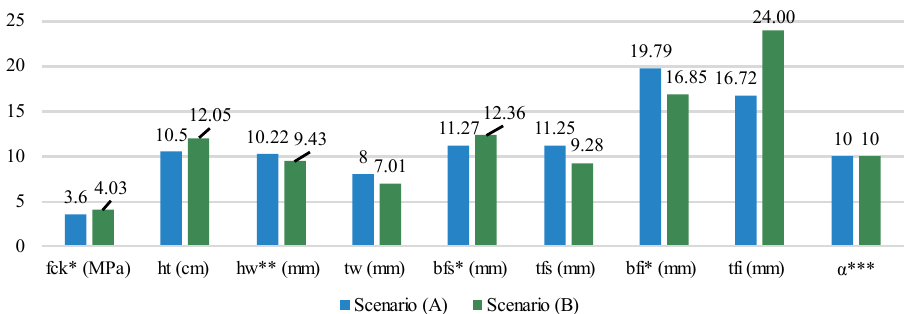
Figure 10. Average optimal values for design variables in each scenario * Values in the y axis divided by 10 ** Values in the y axis divided by 100 *** Values in the y axis multiplied by 10.